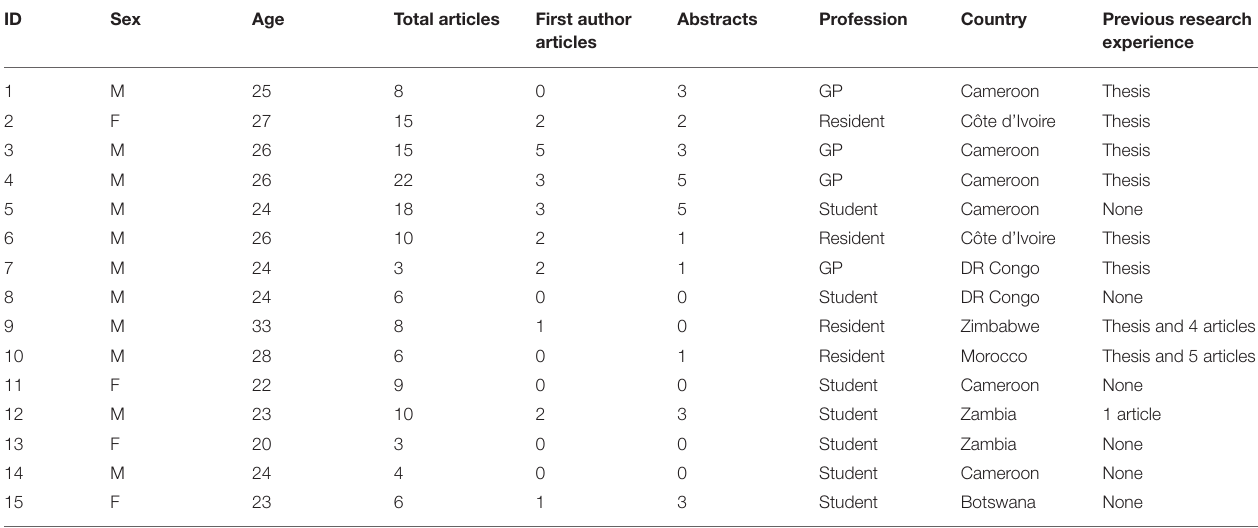
TABLE 1 | Socio-demographic data of the AFAN research incubator